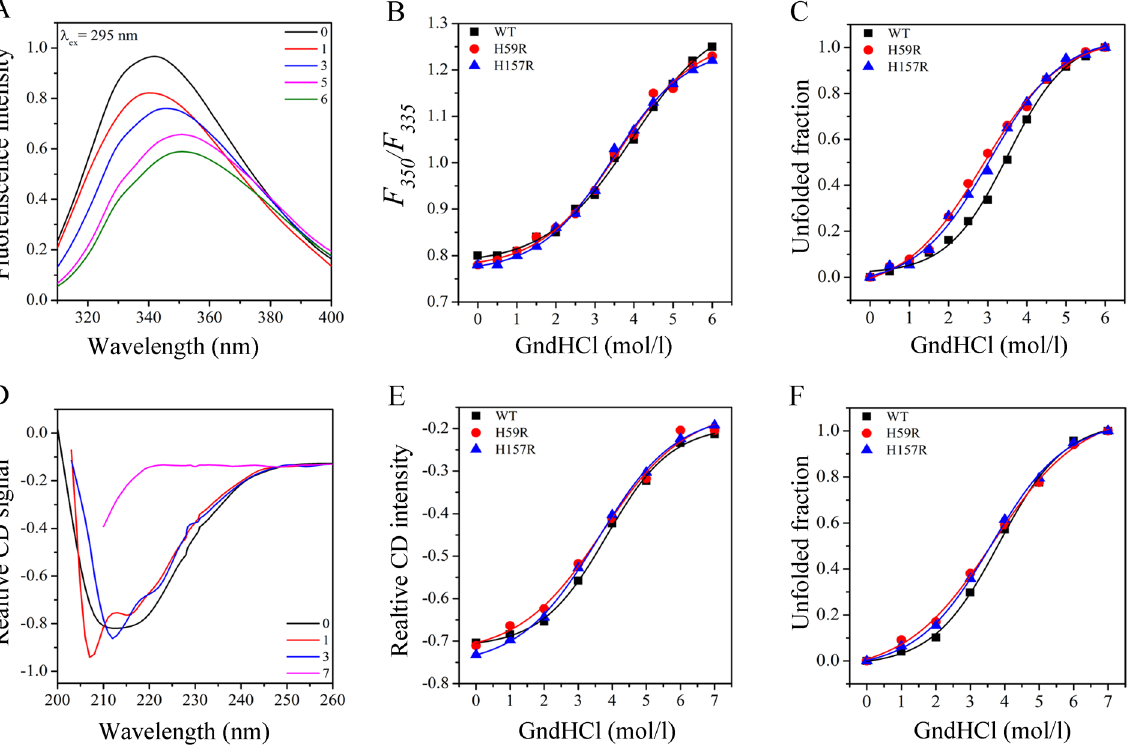
Figure 5. The chemical unfolding curves of Pin1-WT, H59R and H157R. ( A ) The representative fluorescence spectra of Pin1-WT. ( B ) The structural changes in the F 350 /F 335 ratio for the spectra of Pin1-WT, H59R and H157R. ( C ) The chemical unfolding curves of Pin1-WT, H59R and H157R on the basis of fluorescence spectra with λ ex = 295 nm. ( D ) The representative far-UV CD spectra of Pin1-WT. ( E ) The relative intensity of far-UV CD spectra of Pin1-WT, H59R and H157R at 222 nm. ( F ) The chemical unfolding curves of Pin1-WT, H59R and H157R on the basis of far-UV CD spectra.